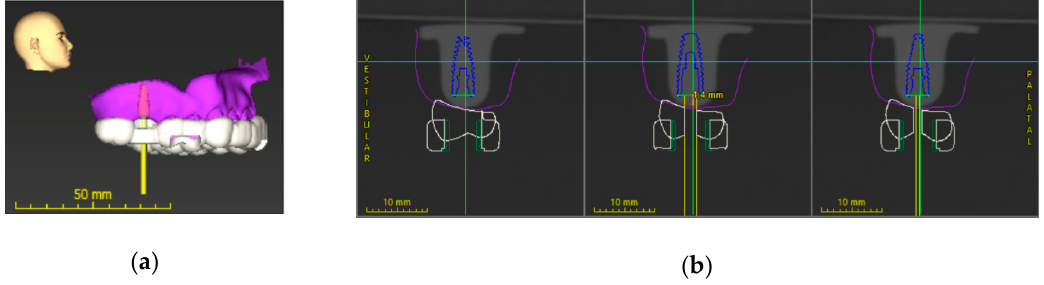
Figure 1. ( a ) 3D and ( b ) 2D cross-sectional illustration of tooth 16 implant position and surgical guide planning on a model.